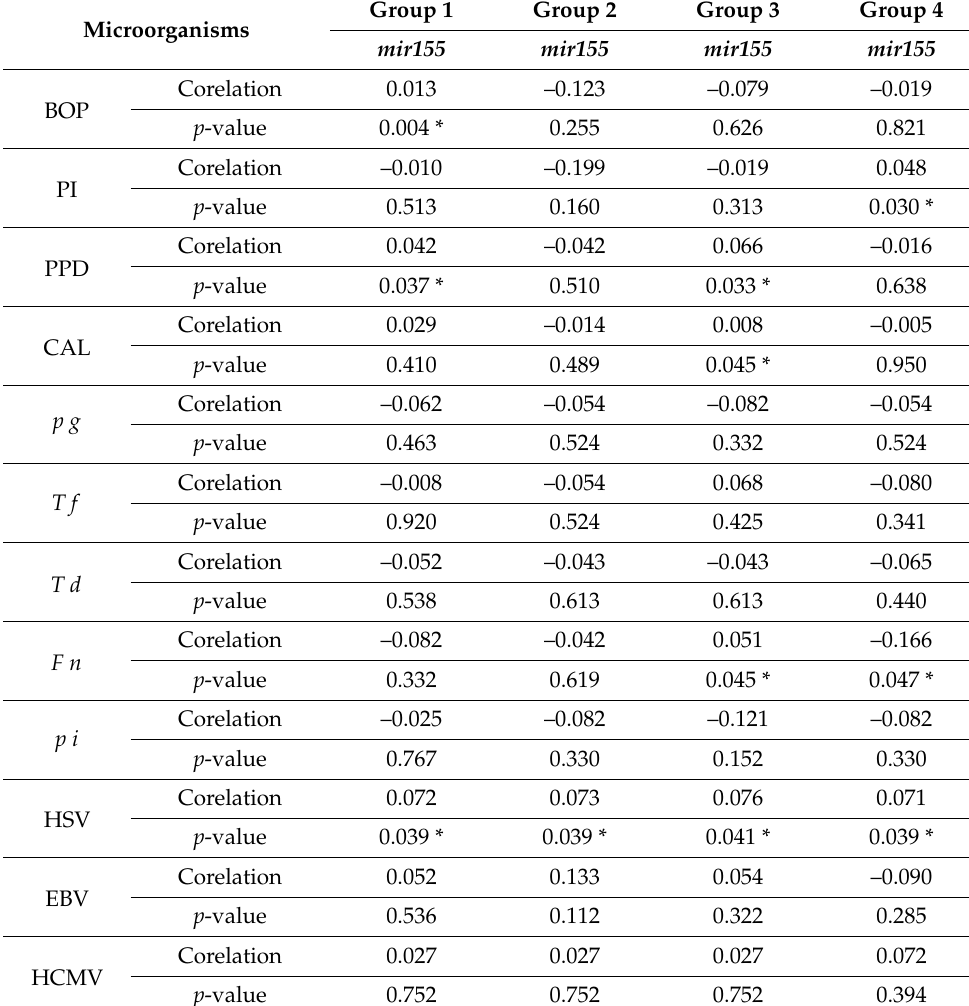
Table 6. Correlation of mir155 with Periodontal Microorganisms among